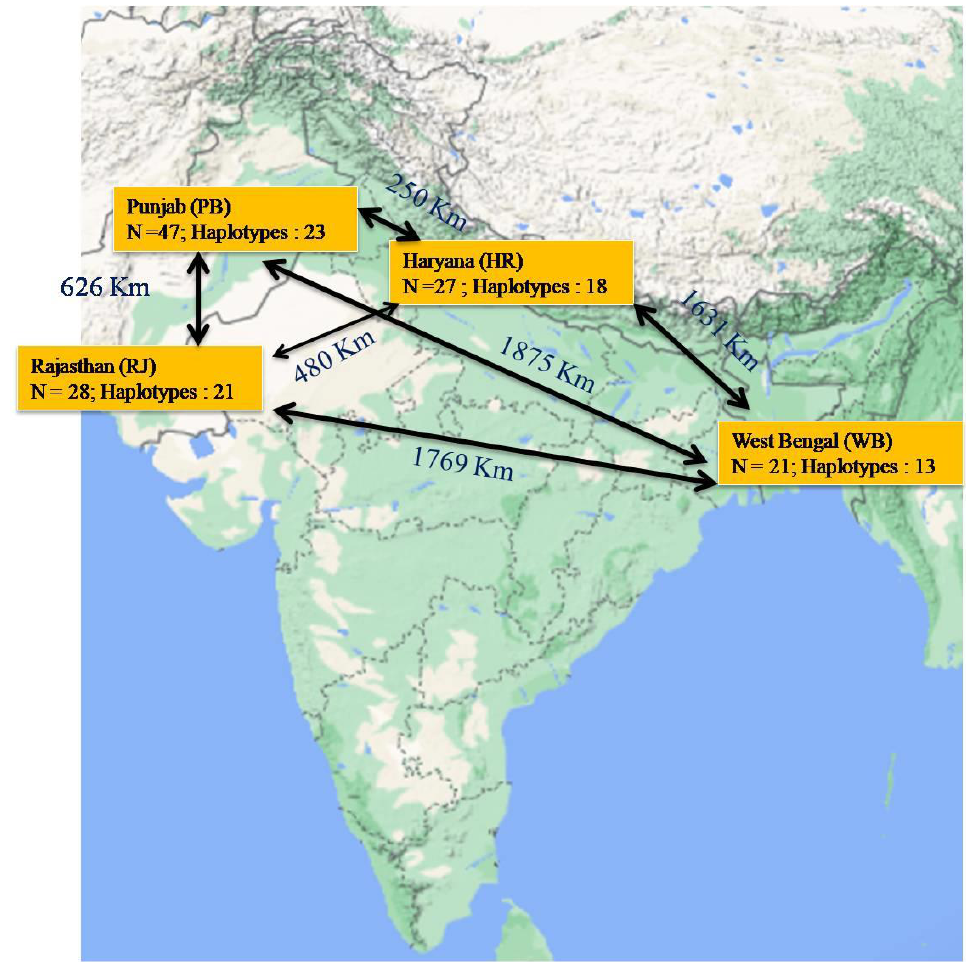
Figure 2. Map showing the sample collection sites in Northern wheat belt of India. N= Number of samples; Distance between two sample collecting states is mentioned over the black line.